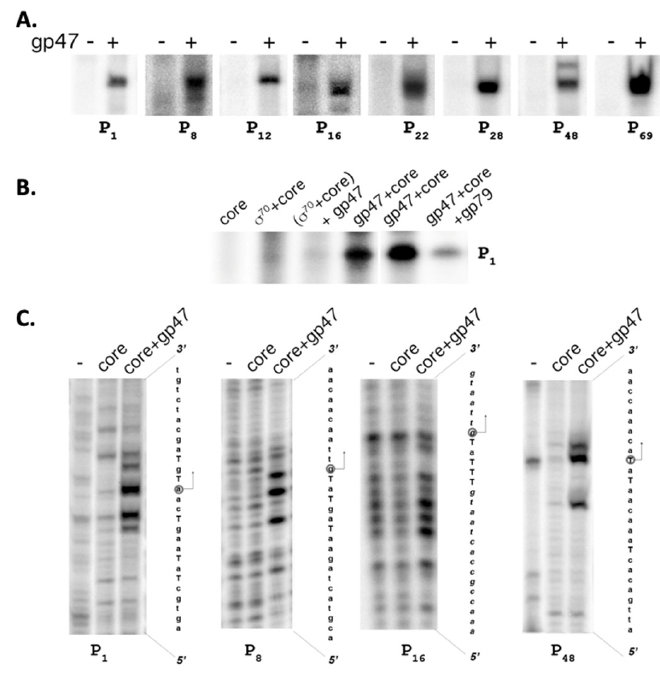
Figure 3. SaPh711_gp47 is a sigma factor required for late promoter transcription in vitro : ( A ) The products of in vitro transcription reaction by E. coli RNAP core enzyme in the presence or in the absence of three-fold molar excess of recombinant SaPh711_gp47 from DNA fragments corresponding to intergenic regions in front of 7-11 genes 1 , 8, 16 , 22, 28, 48 and 69 are shown. The mapping of the product of P 48 transcription by primer extension is shown in Figure 2A. ( B ) Analysis of in vitro transcription products by E. coli RNAP core in the presence of σ 70 , SaPh711_gp47 or both and with the addition of phiEco32 inhibitor of σ 70 transcription gp79 from a DNA fragment corresponding to intergenic regions in front of 7-11 gene 1 . The reaction products were separated in a 10% denaturing polyacrylamide gel and visualized using PhosphorImager. ( C ) DNA fragments harboring indicated late 7-11 promoters, terminally labeled at the template strand, were probed with KMnO 4 in the absence or in the presence of core RNAP with or without SaPh711_gp47. The reaction products was separated by 6% denaturing PAGE and revealed using PhosphorImager. Mapping of permanganate sensitive bands to DNA sequence is shown at the right of each